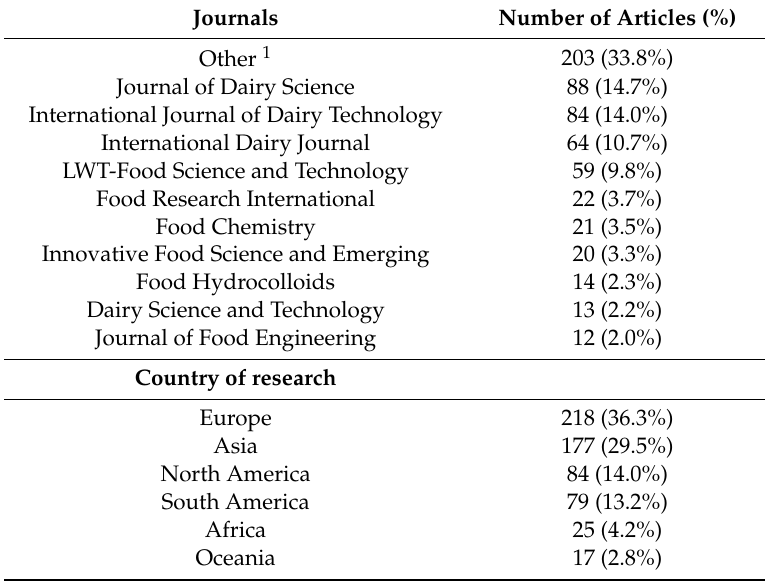
Table 1. Data for journals and countries studied for measuring milk